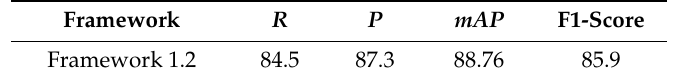
Table 6. R, P, mAP, F1-socre of proposed Framework1.2 on DOTA